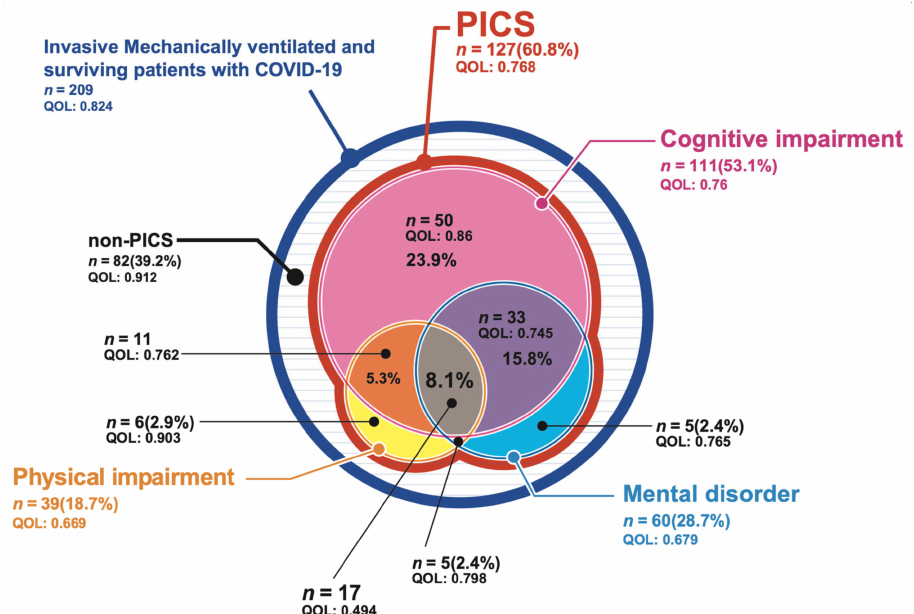
Figure 3. The prevalence of post-intensive care syndrome (PICS) after intensive care unit (ICU) discharge on the second PICS survey. The details of the prevalence of PICS, as well as the EQ-5D-5L values for each, among patients with coronavirus disease 2019 (COVID-19) who required ventilatory management during admission. EQ-5D-5L values are expressed as quality of life. PICS: post-intensive care syndrome; QOL: quality of